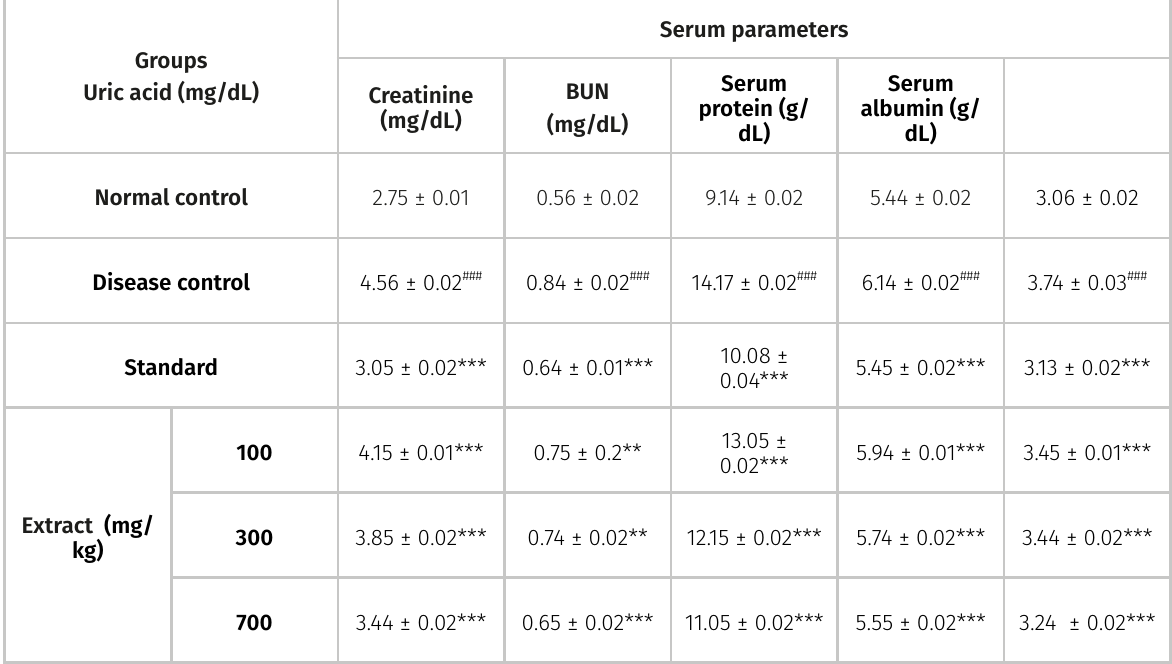
Table VIII. Effect of S. hispanica seeds extract on the serum parameters. The values are expressed as mean ± SEM, (n=6), ### p < 0.001 as compared to the normal control, ** p < 0.01, *** p < 0.001 as compared to the disease control group.